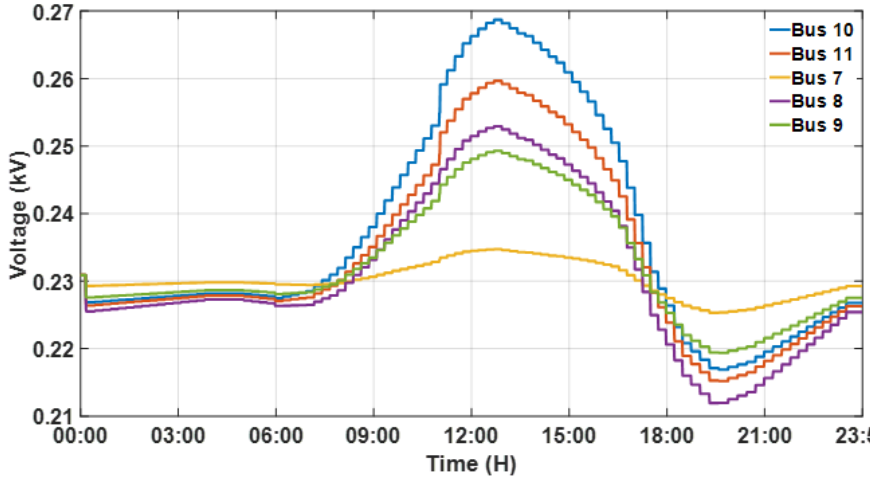
Figure 13. Voltage profiles without CVC.